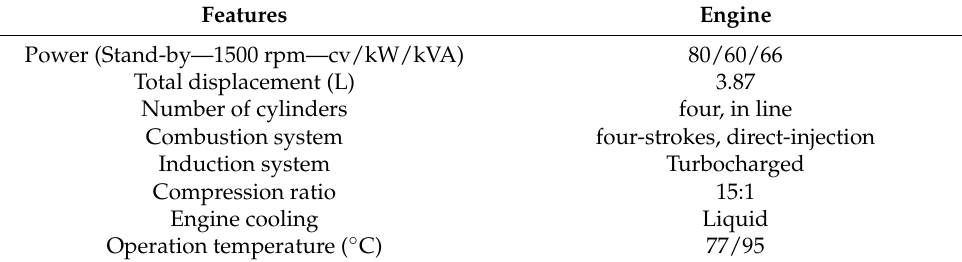
Table 2. Diesel engine features.